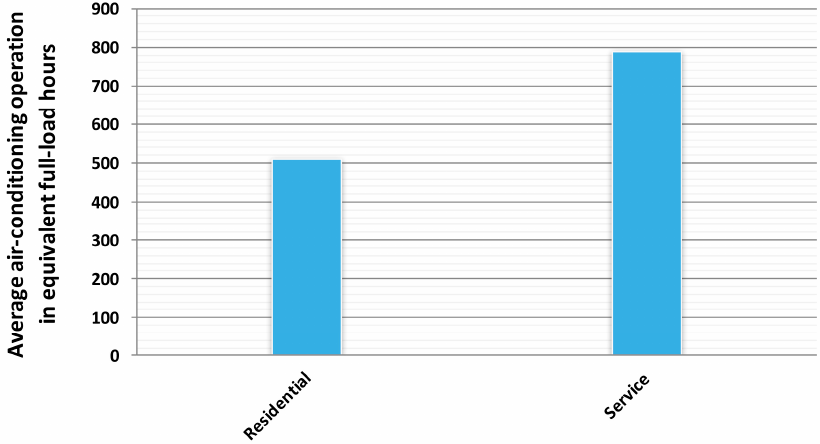
Figure 7. Distribution of average AC equivalent full-load hours, residential and service sectors, EU15 (see references in the Appendix A, Table A2).